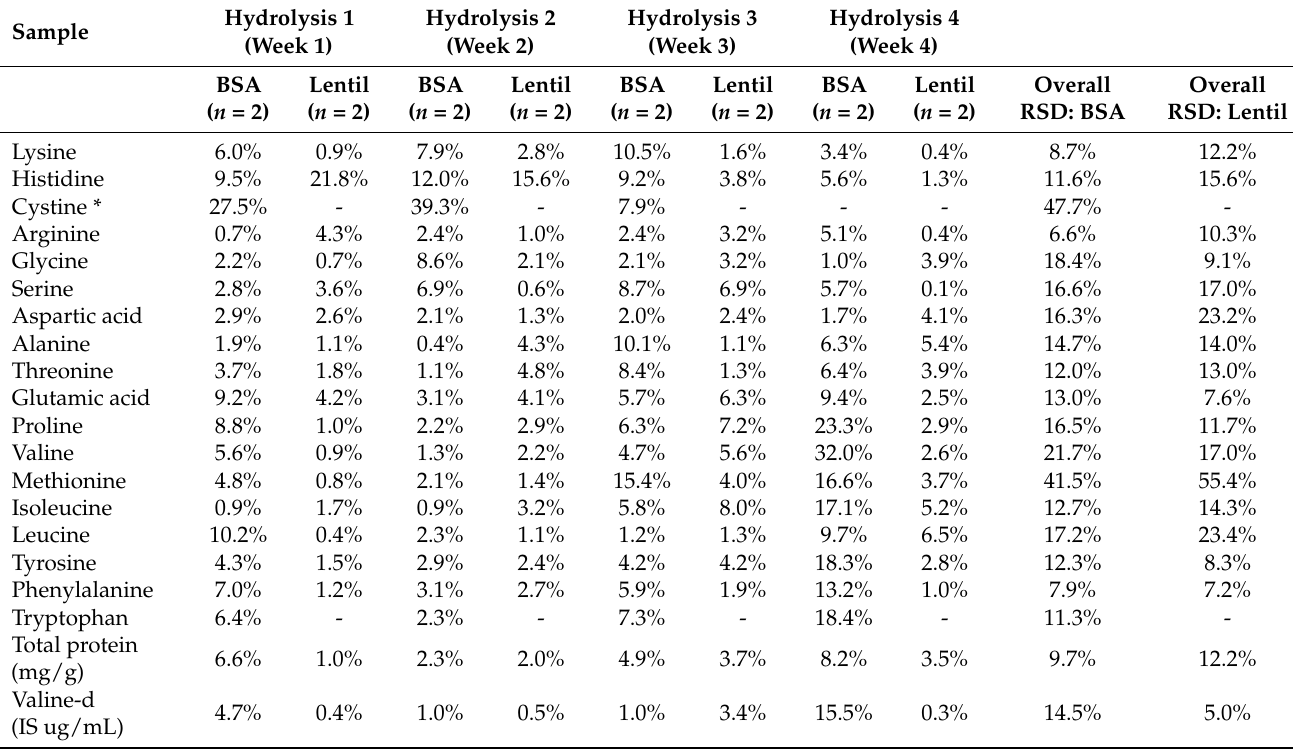
Table 3. The average relative standard deviations (RSD) of amino acid content of BSA and lentil samples 1 injected two times in four hydrolysis batches on two different matrices (lentil and BSA) analysed over 4 weeks.